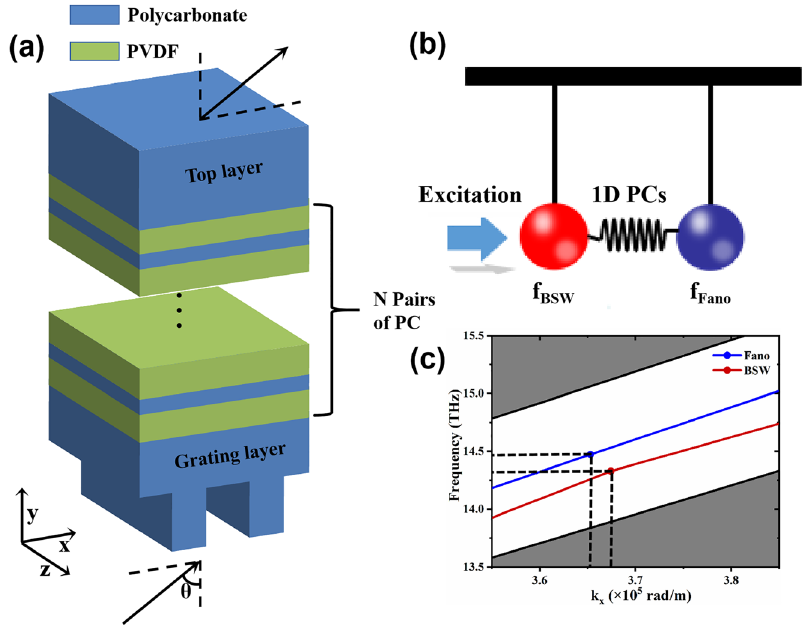
Figure 1: (a) Schematic illustration of the 2D-Blochsurface wave (BSW)-structurethat consists of top layer, 1D photonics crystals (1D PCs), grating layer, and gratings. (b) Schematic illustration of the working mechanism, in which two coupled resona- tors with the corresponding eigen- frequencies f BSW and f Fano are involved. (c) Photonic dispersion diagram of the proposed BSW structure, note that red and blue lines are associated with the disper- sion of BSW and Fano modes, as mainly con fi ned within grating and top layers, respectively. The white zone represents the stopband, and the gray zone represents nonradiative modes. Note here gratings were added so that α = 1, and t top = t grl = 2 μ m so that γ =